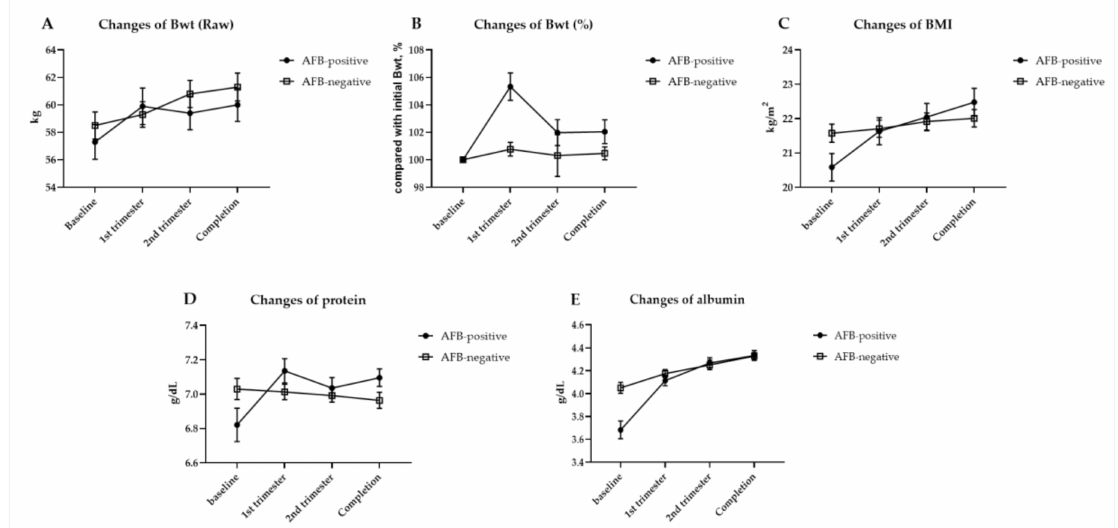
Figure 2. Changes from baseline in body weight ( A ), % changes in body weight compared with baseline ( B ), body mass index ( C ), serum protein levels ( D ), and serum albumin levels ( E ) during anti-TB treatment; the observed mean changes from baseline over the period of anti-TB therapy in the AFB smear-positive and negative groups. Bwt, body weight; BMI, body mass index; AFB, acid-fast bacilli.